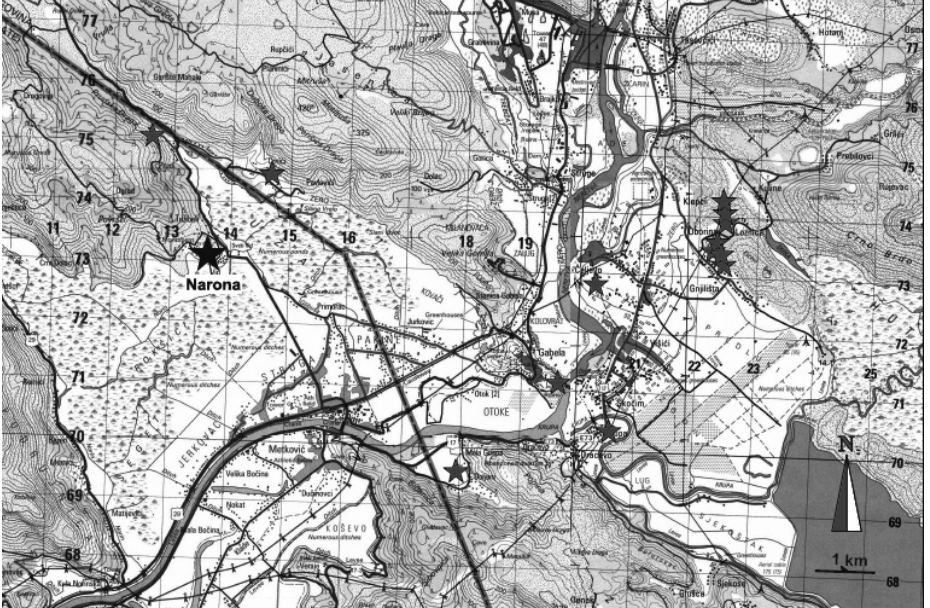
Figure 8: The Roman villas in the ager of Narona, approximate locations marked with small